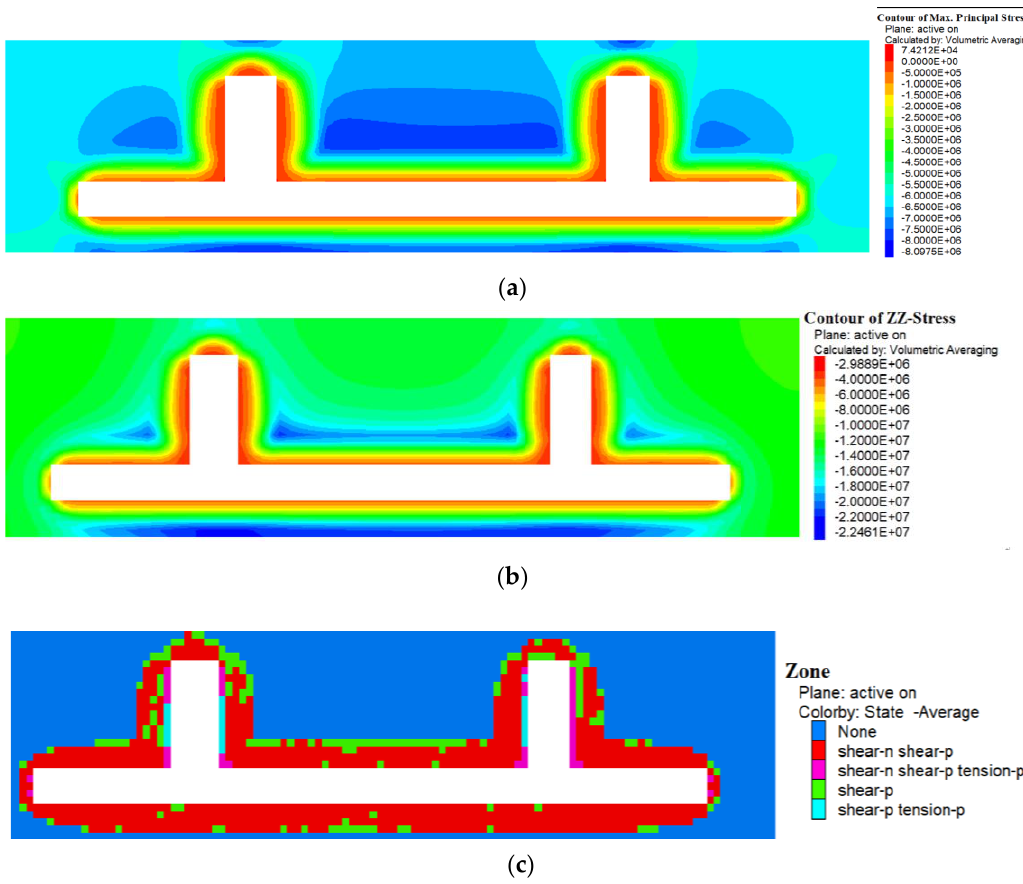
Figure 6. Surrounding rock variation characteristics for h = 3 m. ( a ) Maximum principal stress distribution; ( b ) vertical stress distribution; and ( c ) plastic differential distribution.